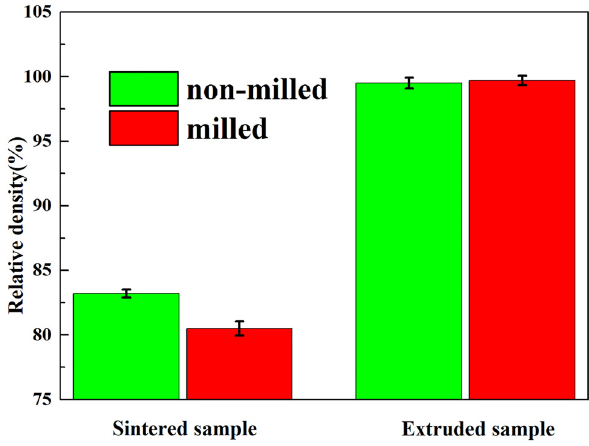
Figure 5: Relative density changes after sintering and extrusion.